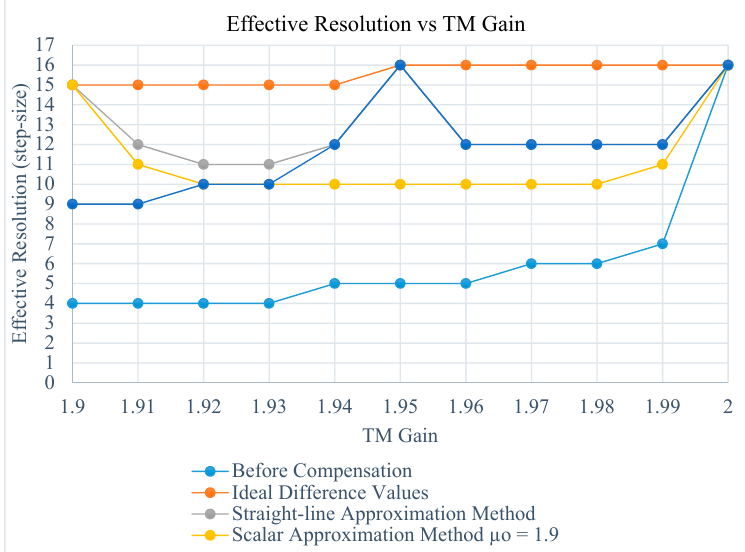
Figure 18. Plot of effective resolution versus TM gain when employing approximation methods.